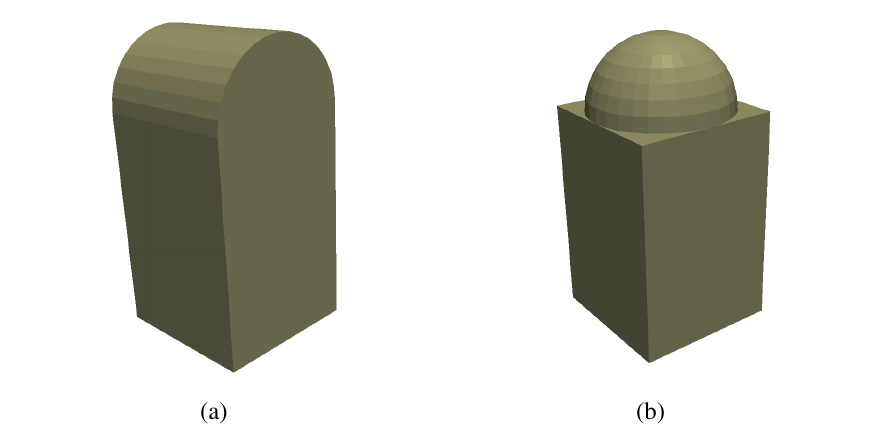
Figure 8. Diagram of the different curved roof shapes investigated. ( a ) Vaulted roof; ( b ) spherical